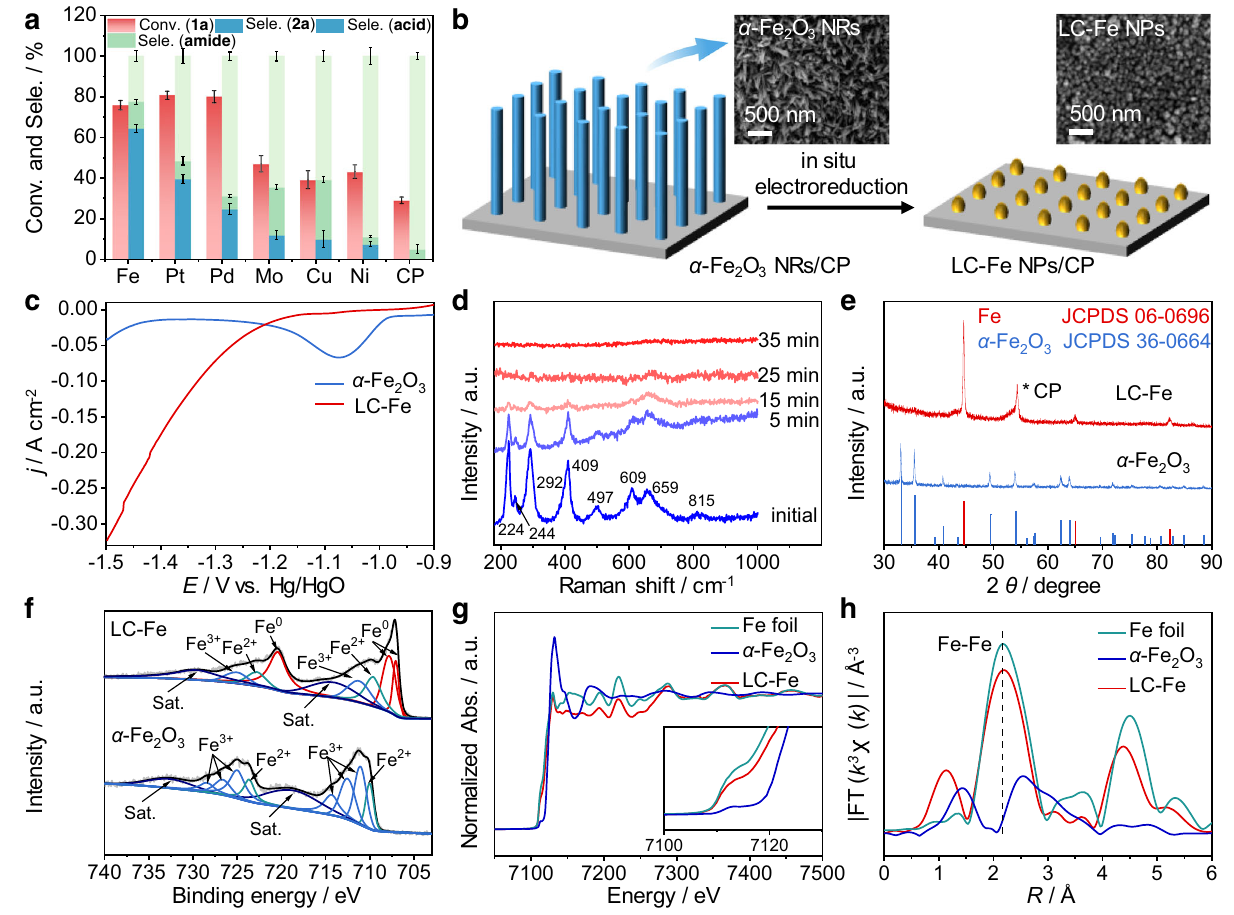
Fig. 2 | Synthesis of CP-supported LC-Fe NPs via electroreduction of α -Fe 2 O 3 NRs. a Comparisonresults ofconverting 1a to 2a overdifferent cathodematerials. b A schematic illustration of the electroreduction conversion from α -Fe 2 O 3 NRs to LC-FeNPsandtheircorrespondingSEMimages. c LSVcurvesof α -Fe 2 O 3 NRsandas- prepared LC-Fe NPs at a scan rate of 10mVs − 1 in 1.0M KOH solution. d Time- dependent in situ Raman spectra of α -Fe 2 O 3 NRs collected at − 1.9V in 1.0M